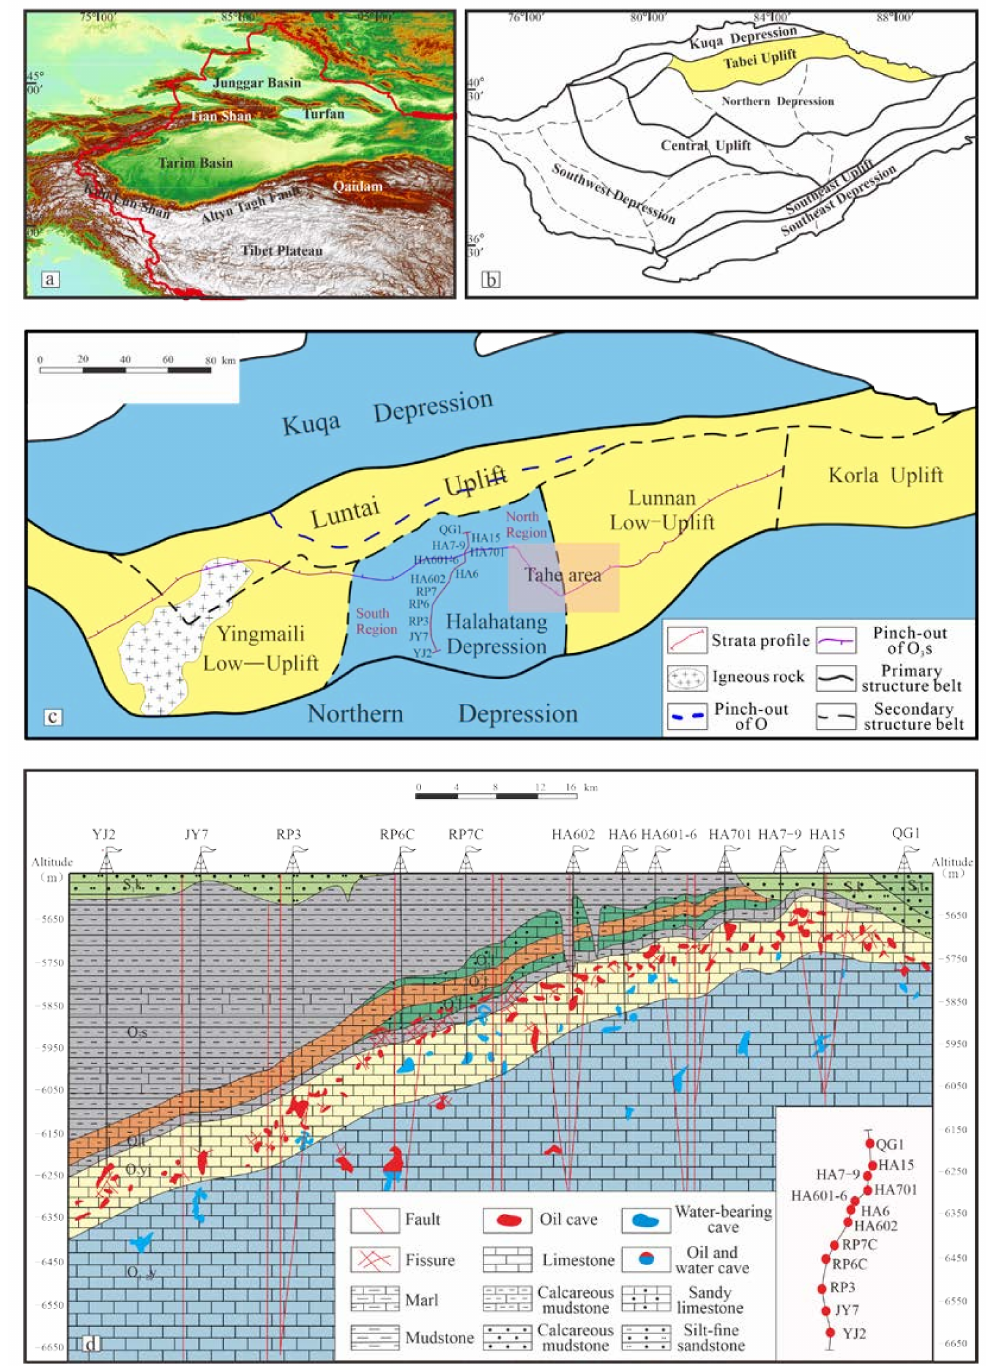
Figure 1. Structure schematic map of the study area; ( a ) the location of Tarim Basin in NW China; ( b ) tectonic units of Tarim Basin, including the Kuqa Depression, Tabei Uplift, Northern Depression, Central Uplift, Southwest Depression, Southeast Uplift and Southeast Depression, yellow area means Tabei Uplift; ( c ) tectonic units of Tabei Uplift and location of Halahatang depression, two regions are divided by the pinch-out line of O 3 s in Halahatang depression, “North Region” and “South Region” means “north of the pinch-out line of O 3 s” and” south of the pinch-out line of O 3 s”, respectively. The same as below. Pink area means Tahe area which is mentioned in chapter 4.1; ( d ) cross-well